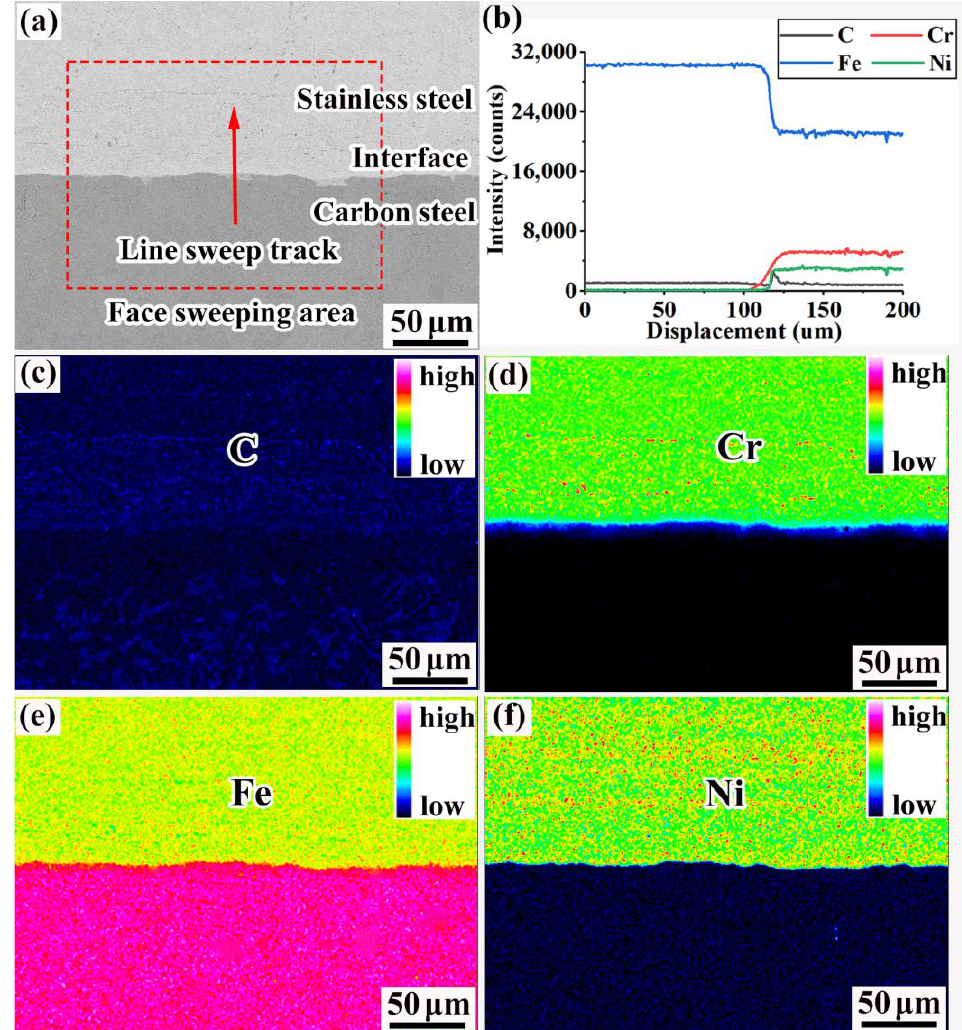
Figure 7. Line and surface scanning results for each element of the composite interface: ( a ) line-sweep track and surface-sweep area, ( b ) line scanning results for each element [30], ( c ) surface scanning results for C, ( d ) surface scanning results for Cr, ( e ) surface scanning results for Fe, and ( f ) surface scanning results for Ni.